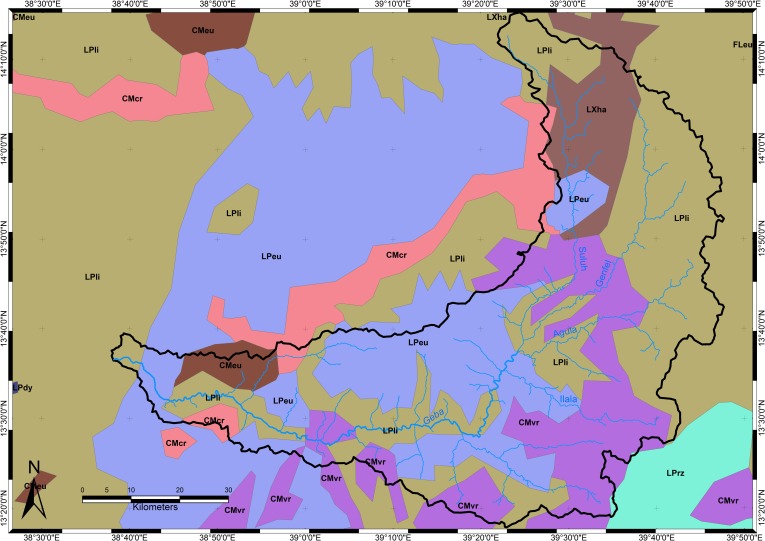
Soil types in Giba catchment, according to the Soil Atlas of Africa [24], which, for Ethiopia, is based on work carried out for FAO in the 1980s [22].Soil types, by decreasing order of occurrence: LPli = Lithic Leptosol; LPeu = Eutric Leptosol; CMvr = Vertic Cambisol; LXha = Haplic Lixisol; CMcr = Chromic Cambisol; LPrz = Rendzic Leptosol.